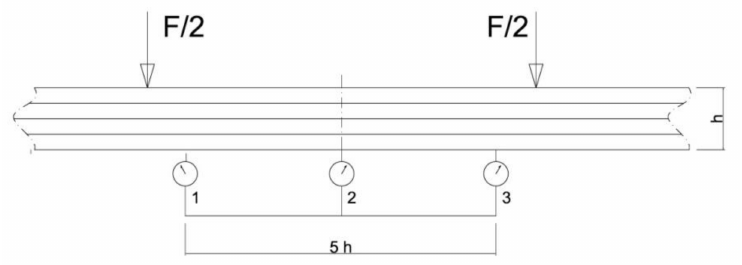
Figure 4. Layout of the distributed mechanical